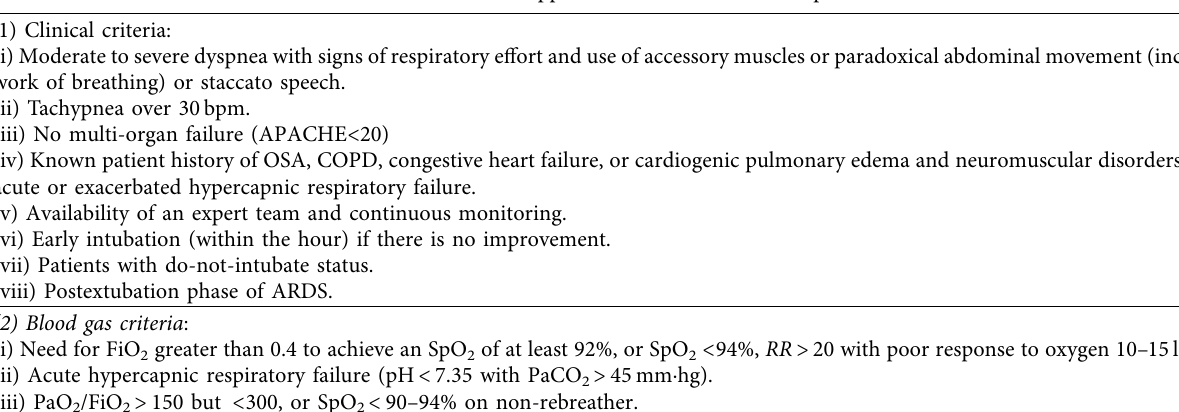
Table 1: Criteria for application of NIV in selected patients.